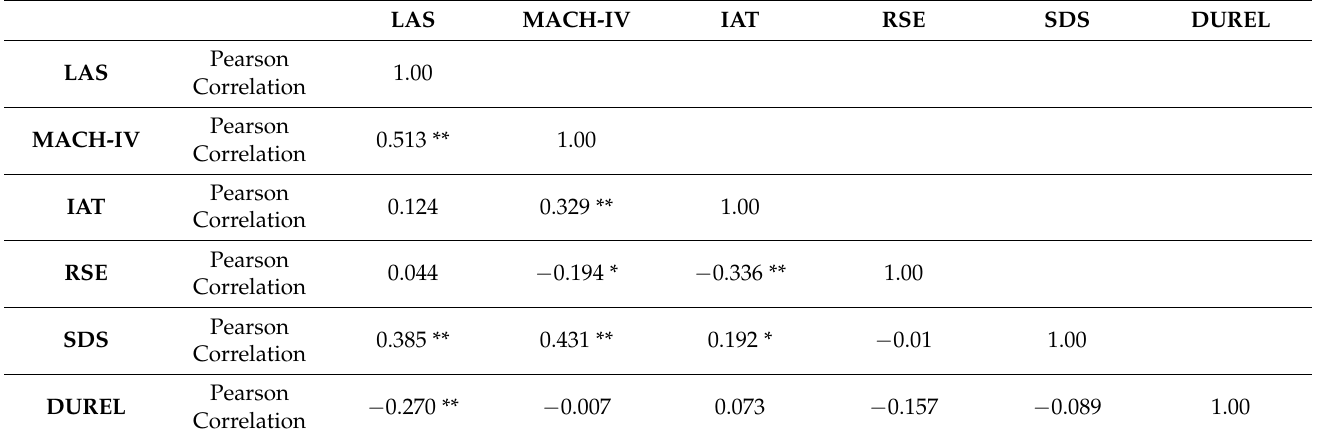
Table 1. Bivariate correlations between our six study